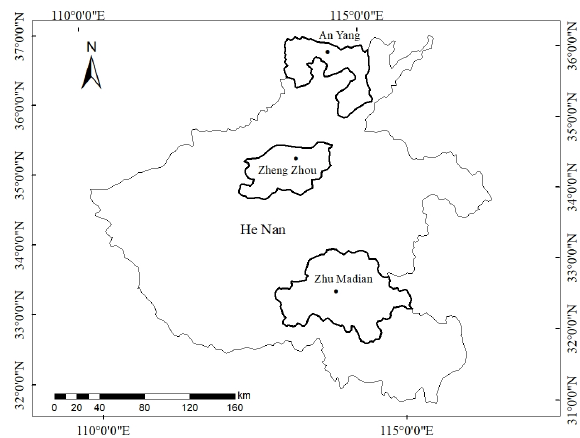
Figure 1. Distribution of research areas.